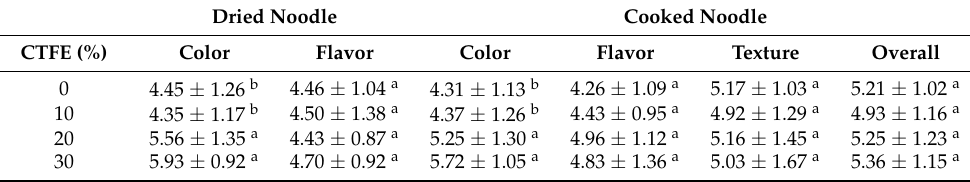
Table 3. Sensory evaluation of dried or cooked noodle fortified with various CTFE levels. Dried